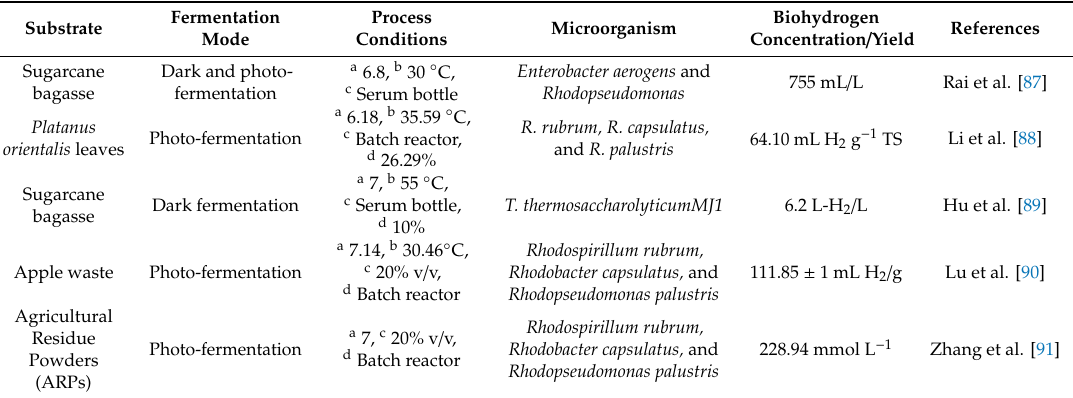
Table 4. Biohydrogen production from agricultural